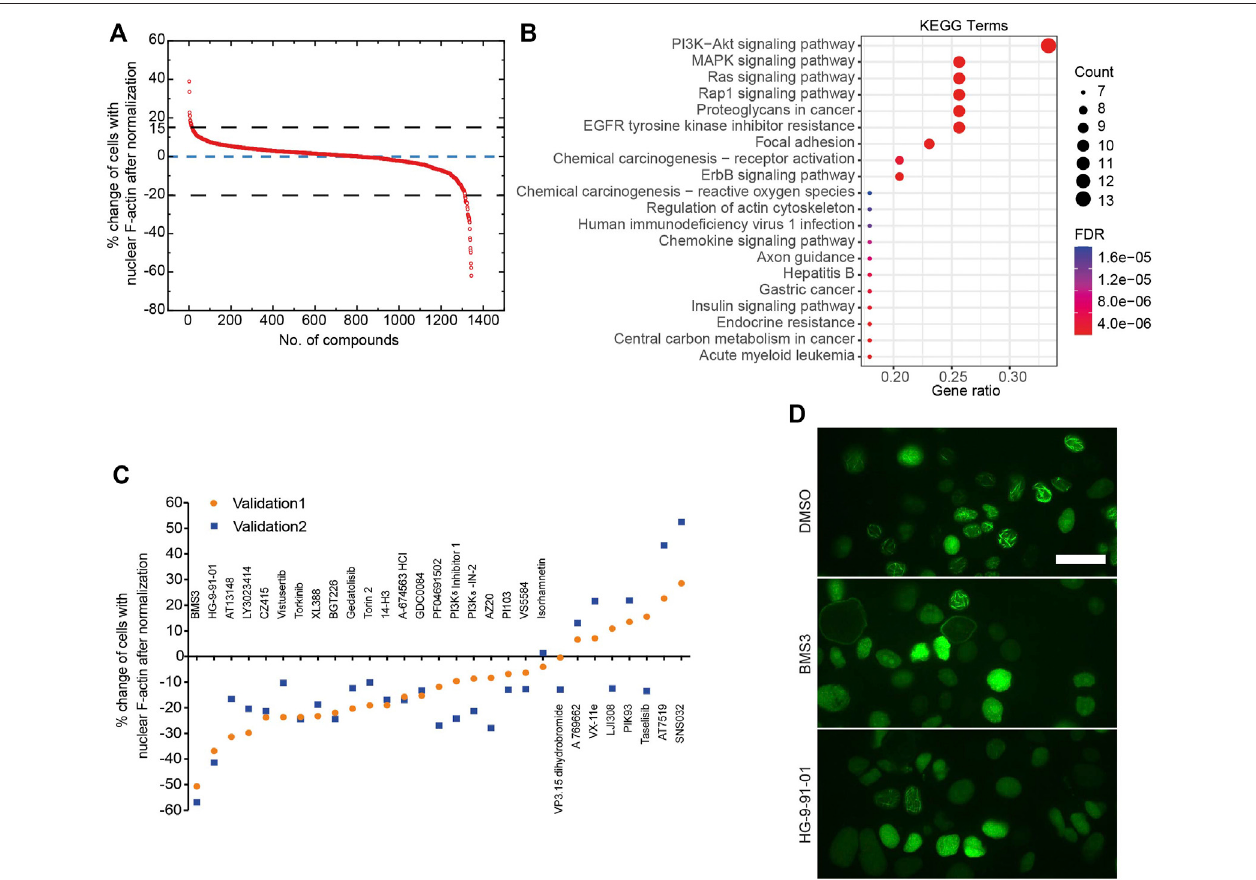
FIGURE 3 | Identi fi cation of kinases that are involved in nuclear F-actin assembly in ovarian cancer cells. (A) , Summary of the primary screen using 1247 compounds (small molecule inhibitors). Thenormalized values for OVCA432-nAc-citrine cells treatedwithindividual inhibitorsare shown. (B) , KEGG analysis ofproteins potentially targeted by the compounds, that reduce the percentage of cells with nuclear F-actin by more than 20%, or increase the percentage of cells with nuclear F-actinbymorethan15%. (C) ,Theeffectof36inhibitors targetingPI3K-Aktpathway onnuclearF-actinproportioninOVCA432-nAc-citrinecells.BMS3wasused as a positive control. The orange circles and blue squares represent two biological replicates. (D) , Representative images of OVCA432-nAc-citrine cells treated with DMSO, BMS3 or HG-9-91-01. Scale bar, 20 µm.